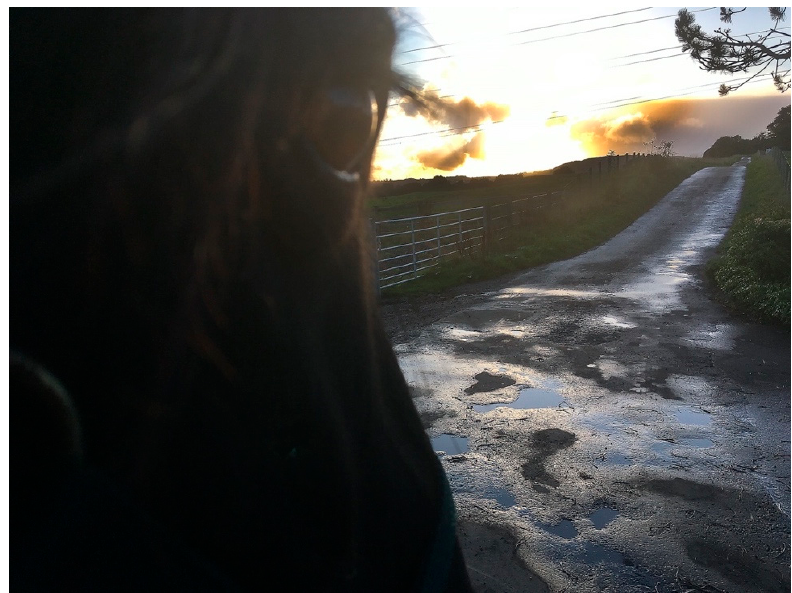
Figure 8. Two things to look for: a lot of rain last night and a rain shower this afternoon. Many big puddles are on the road. Darkness is looking around, but he is also waiting for Tim. He can hear a car is coming, although it is still out of sight and beyond my hearing. (Digital image: Collins & Goto Studio 2021).